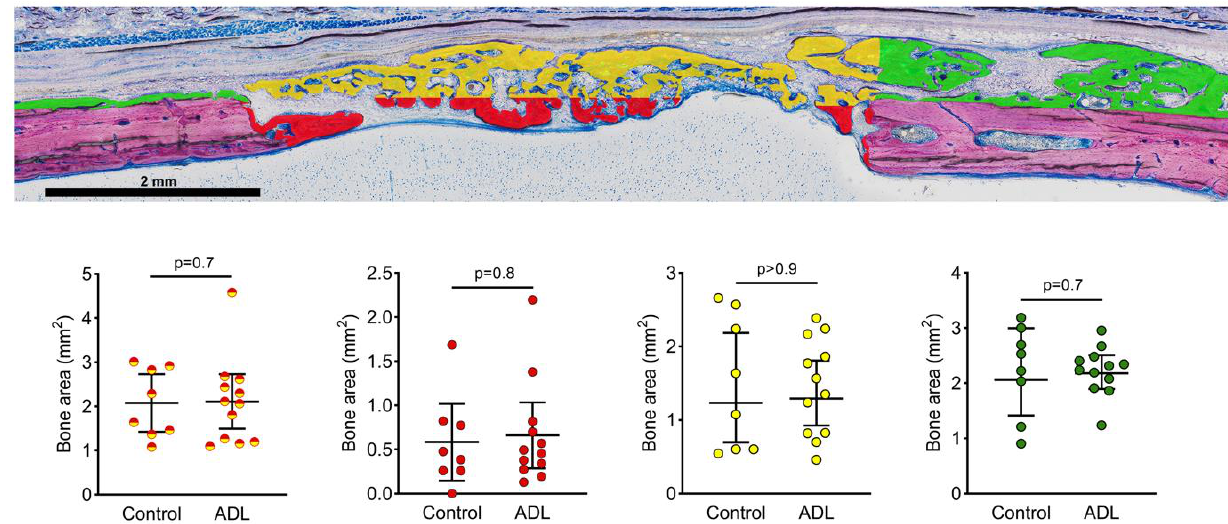
Figure 4. Histomorphometric analysis of the bone area in the defect after four weeks of healing. Histomorphometry was performed at three regions; (red) the central compartment within defect margins, (yellow) the adjacent ectocranial compartments, and (green) the outer compartment on the surface of the host cortical bone. Red-yellow represents the sum of both groups. The groups were compared with Mann–Whitney U test and p values are indicated.